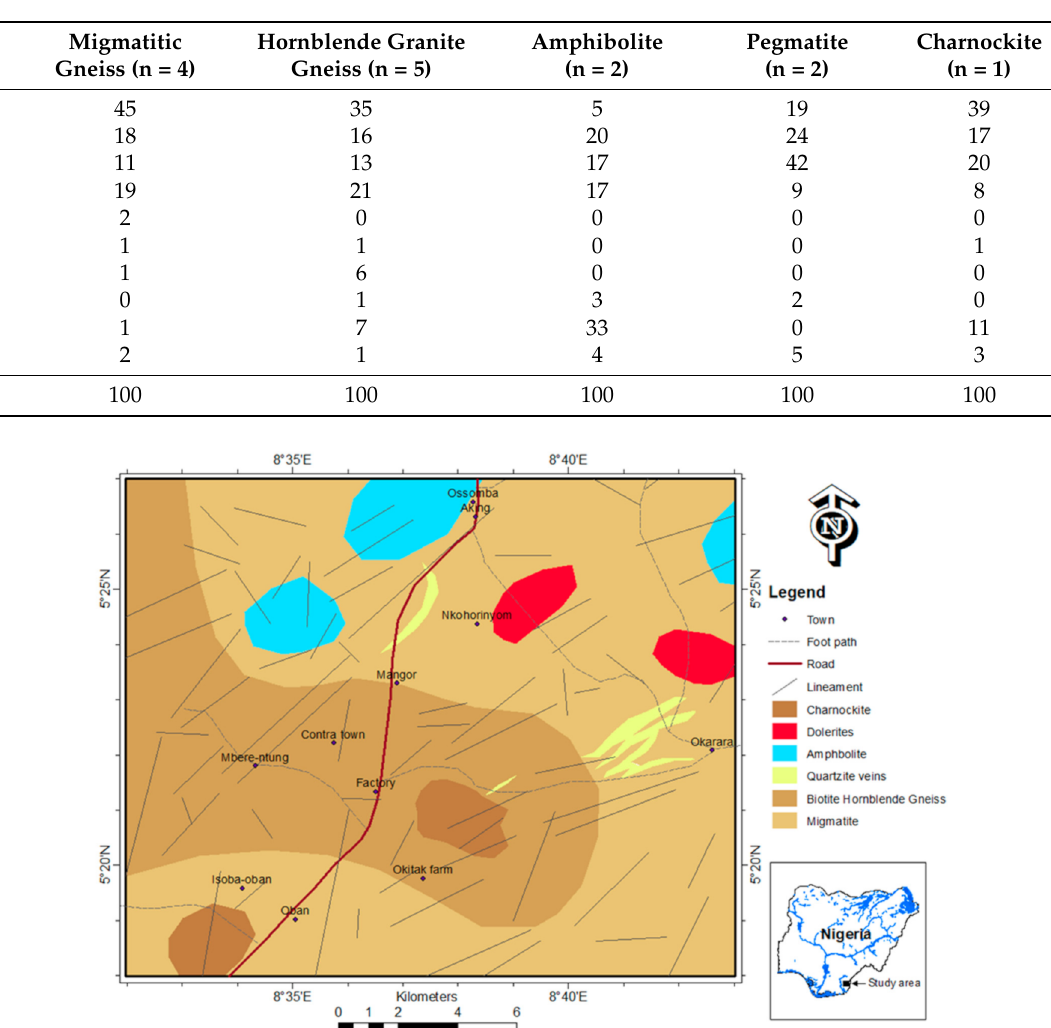
Figure 9. Geological map of the study area showing the rock distribution (modified from